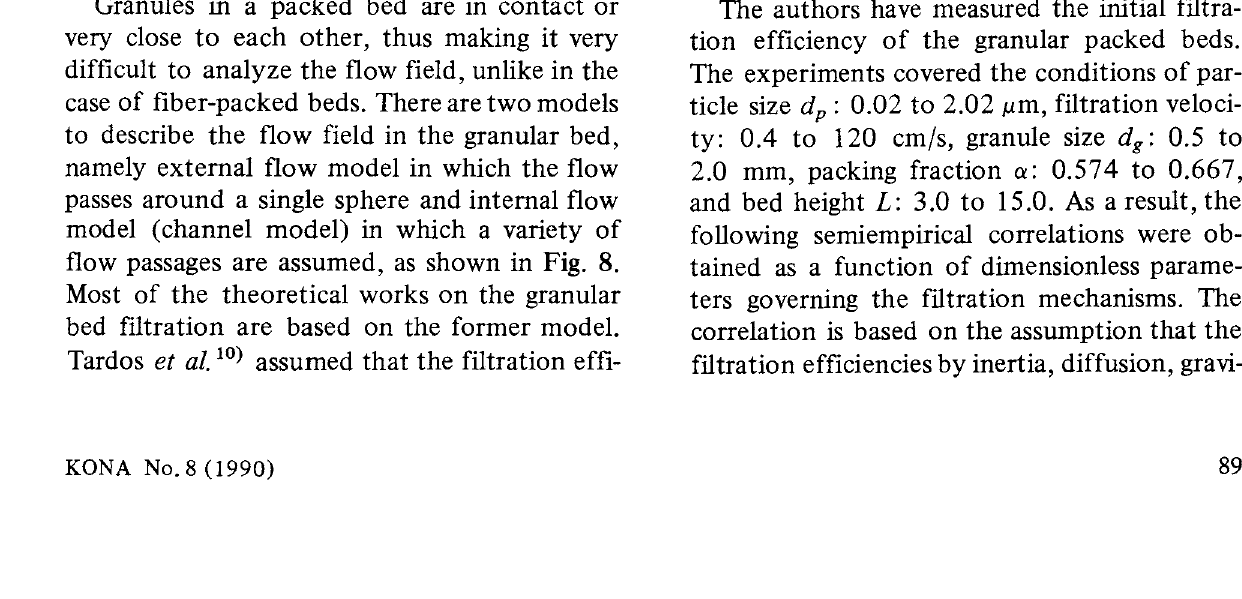
Table 6 Theoretical correlations for